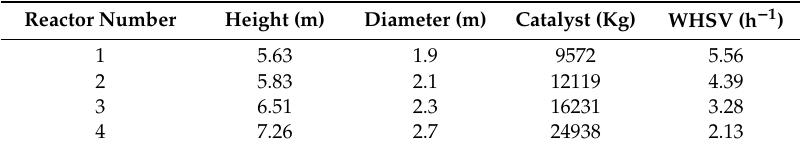
Table 7. Configuration of KRPC Commercial Catalytic Reformer.